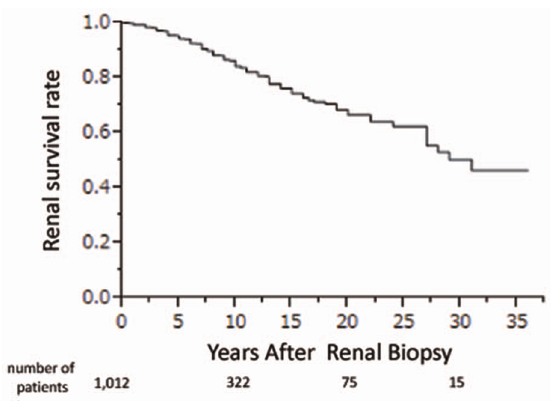
Figure 1. Cumulative renal survival rate from renal biopsy until ESRD in all 1,012 patients with IgAN.